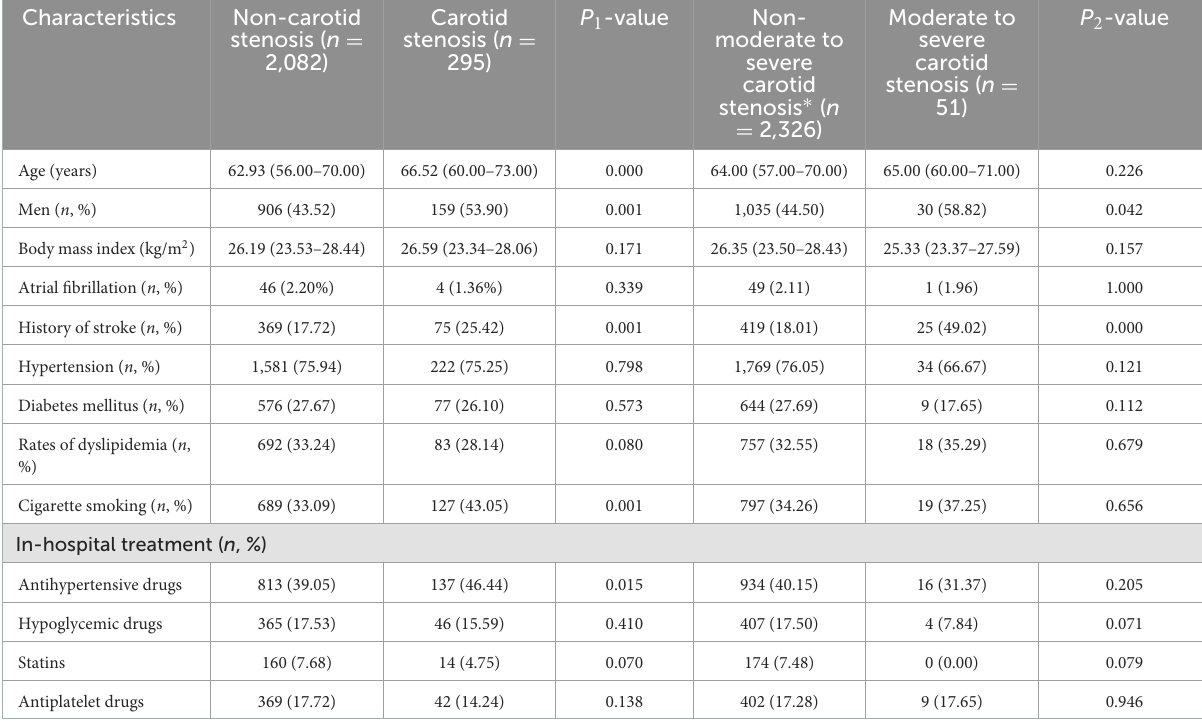
TABLE 1 Demographic characteristics of the study